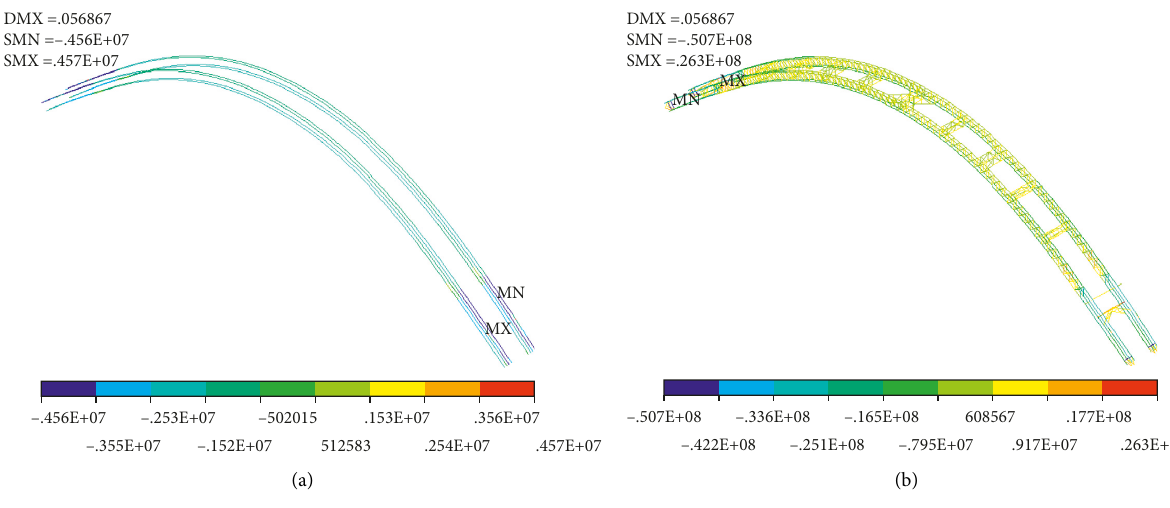
Figure 25: The maximum stress (SMAX) of overall temperature rise of 23.7 ° C: (a) concrete and (b) steel tube.